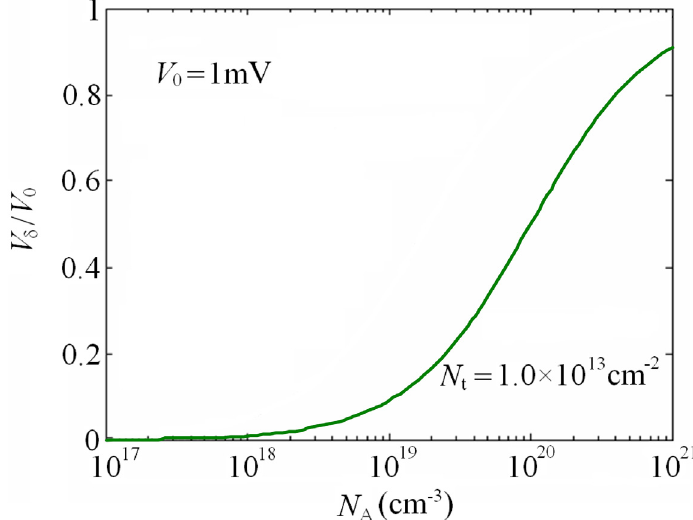
as a function of N 0